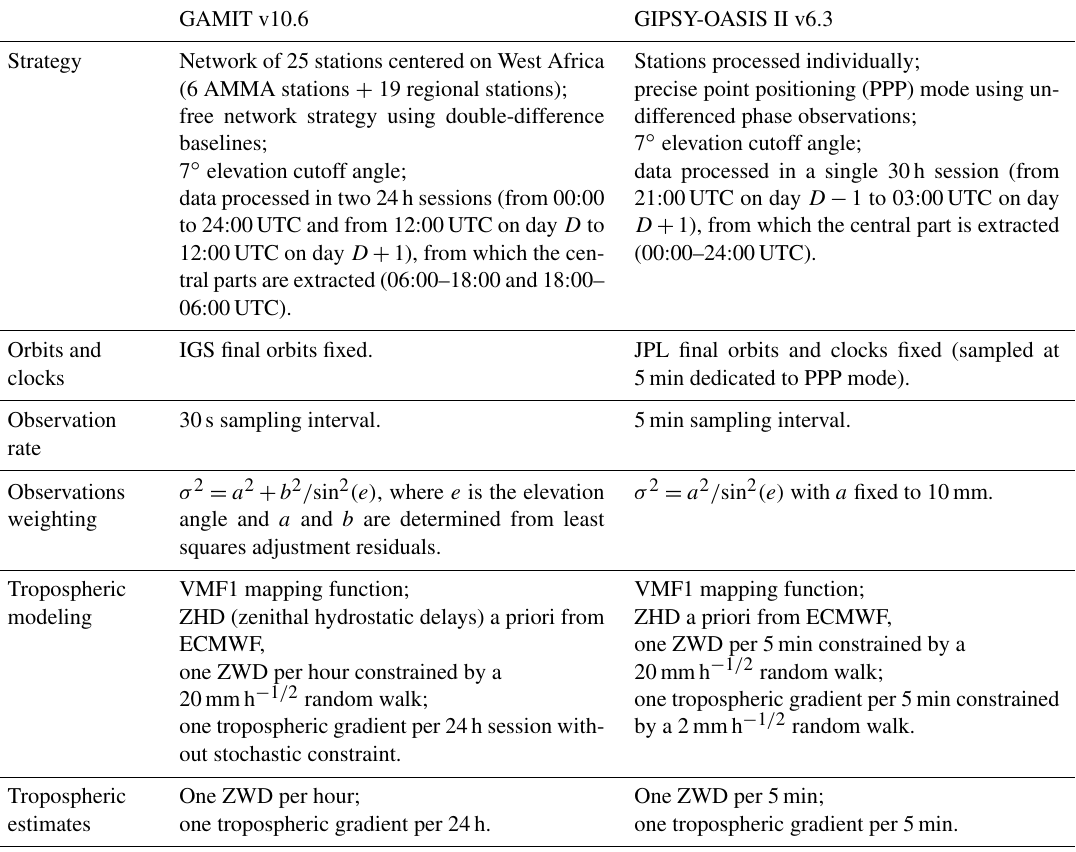
Table 1. GPS data processing details with the GAMIT and GIPSY-OASIS software packages. GAMIT v10.6 GIPSY-OASIS II